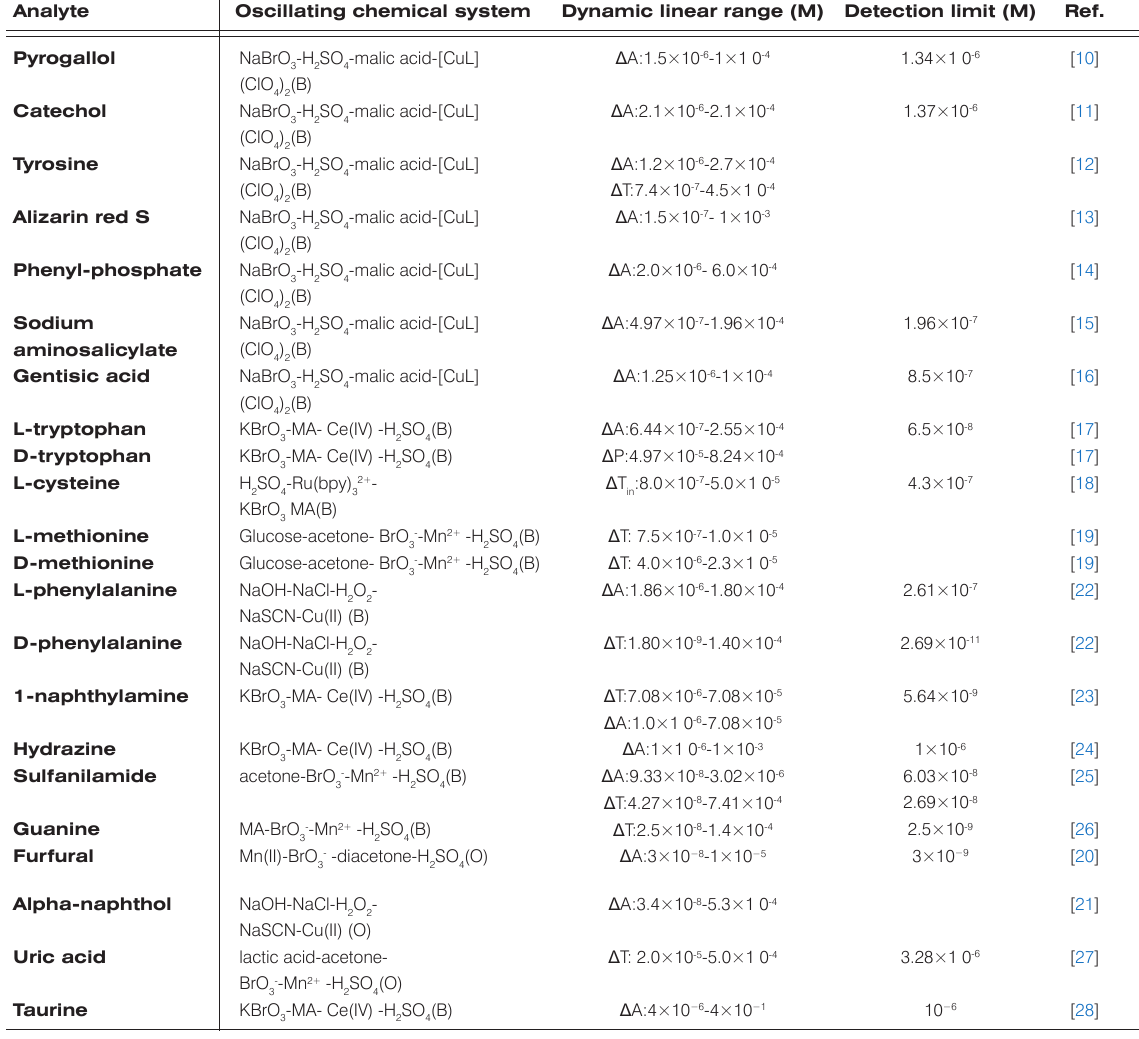
Table 1. Use of regular oscillation in organic